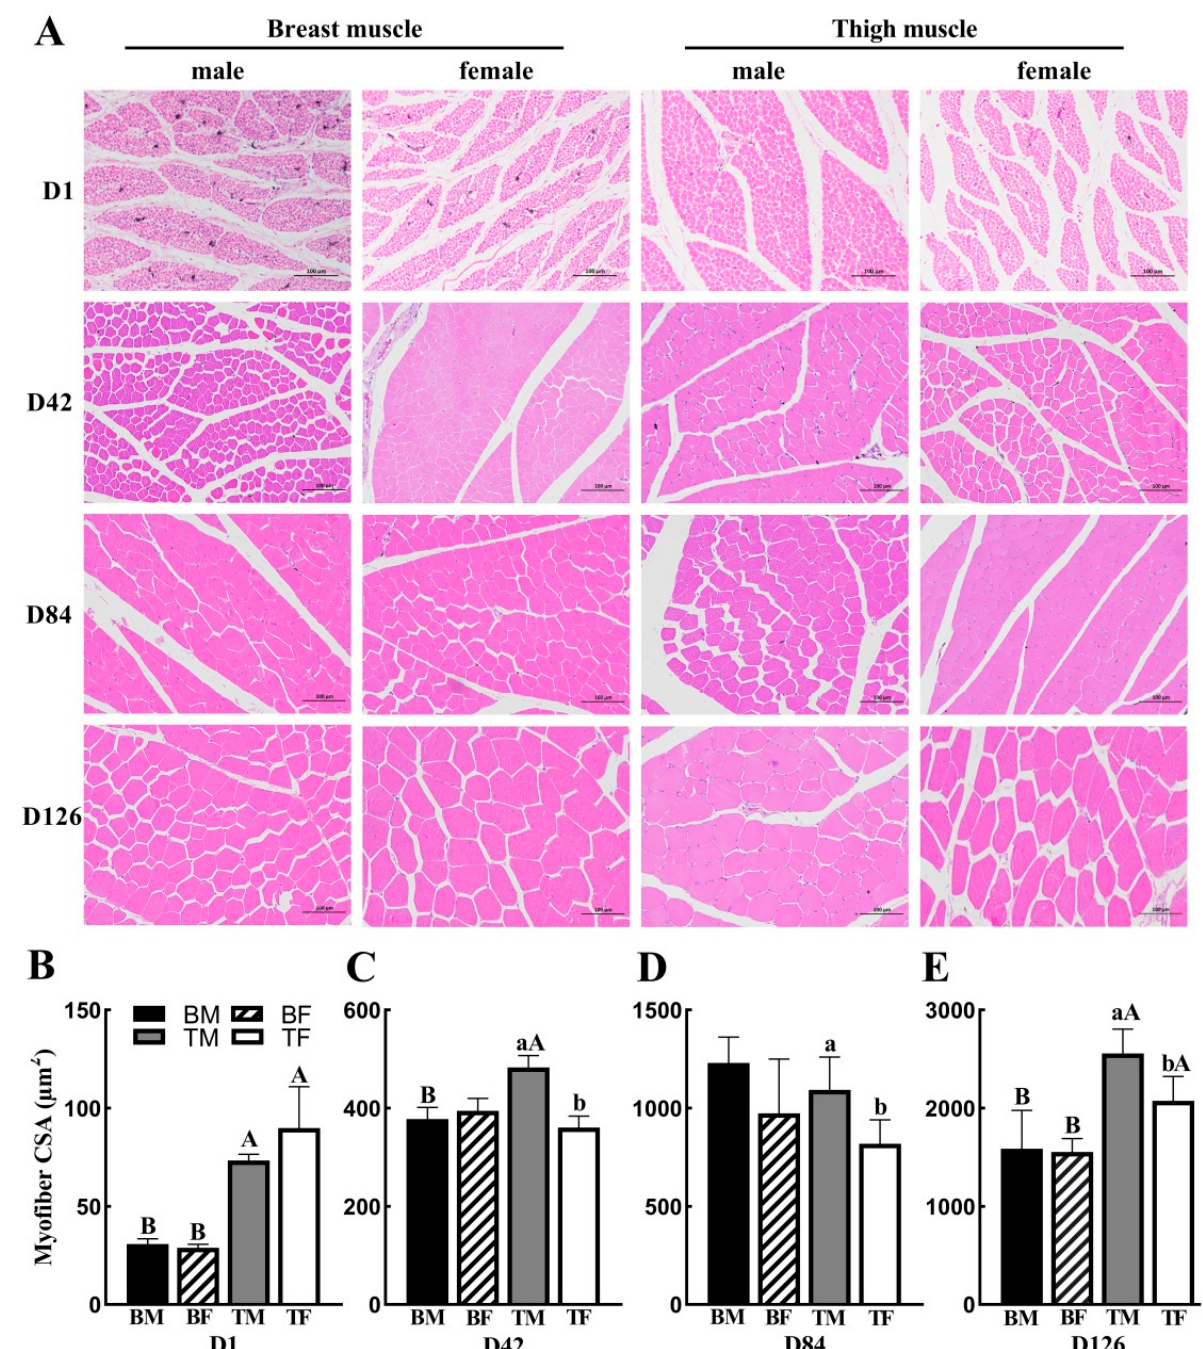
Figure 1. Morphological changes in breast and thigh muscle at D1, D42, D84, and D126 between male and female Wuliangshan Black-bone chickens: ( A ) HE (hematoxylin–eosin) staining of breast and thigh muscles. Scale bar: 100 µ m for D1, D42, D84, and D126; ( B – E ) comparisons of the CSA of breast and thigh muscle fibers. Different lowercase letters on each bar indicate the same type of muscle; there are significant differences ( p < 0.05) between genders. Different capital letters on each bar indicate the same sex; there are significant differences ( p < 0.05) between breast and thigh muscles. Abbreviations: CSA, cross-sectional area; D, postnatal days; BM, breast muscle of male; BF, breast muscle of female; TM, thigh muscle of male; TM, thigh muscle of male.